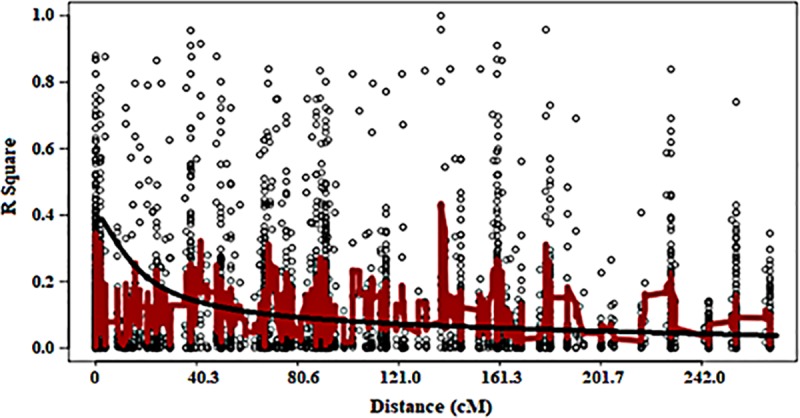
Linkage disequilibrium (R2) plot of all the 15,600 SNP markers across genomes in 97 wheat genotypes used in the mapping study.